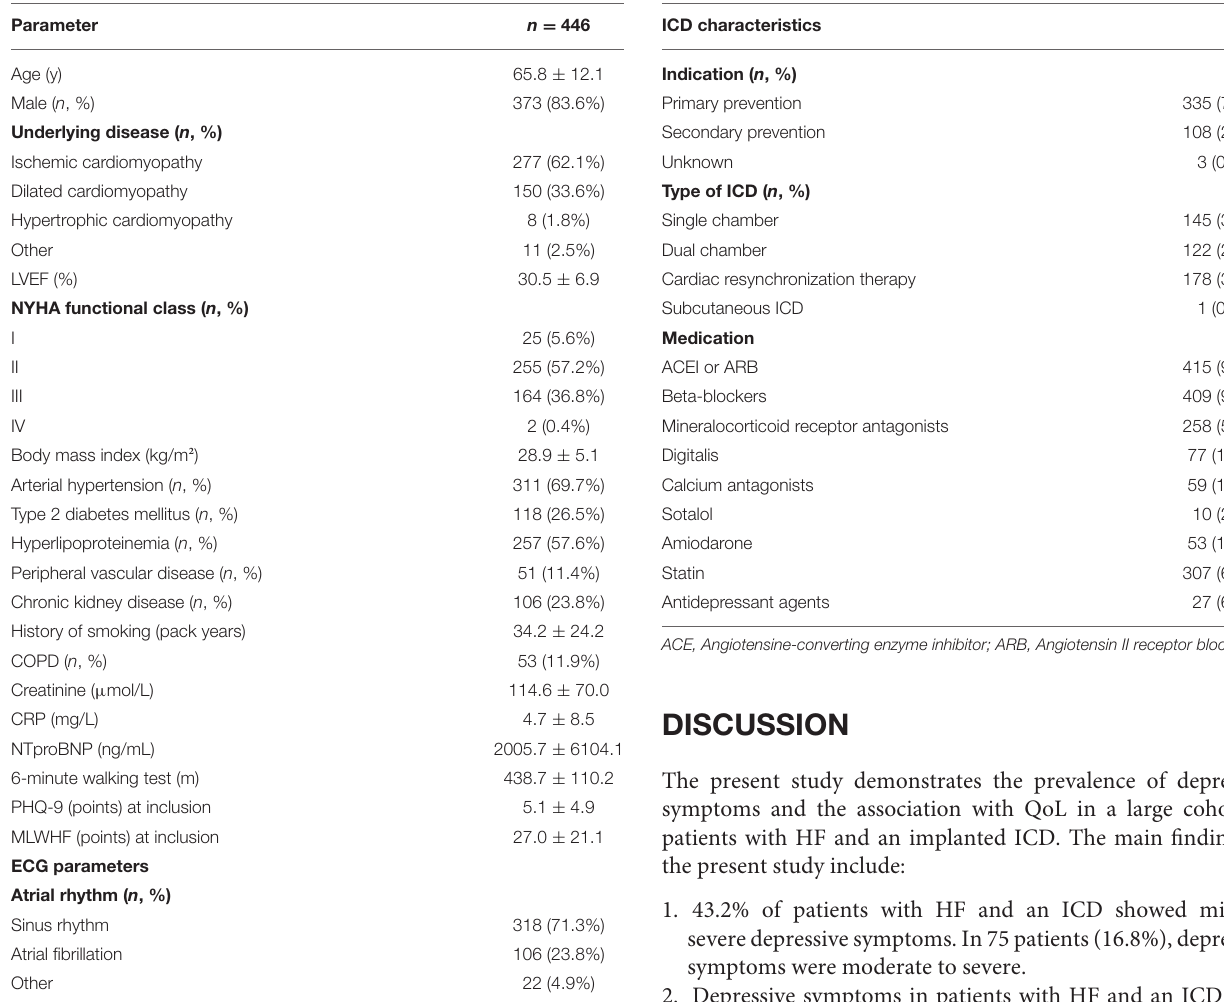
TABLE 1 | Baseline patient characteristics ( n = 446). TABLE 2 | Basic ICD characteristics and